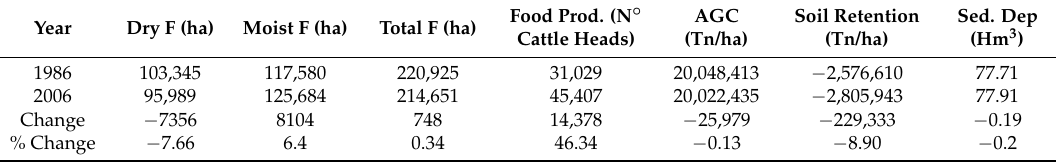
Table 1. Changes in forested area (as the proportion of the area of each forest type), ecosystem services provision, and habitat suitability for birds and medium-large mammals between 1986 and 2006, including total and percentage change. Food Prod. = food production; AGC = above-ground carbon; and Sed. Dep = Sediment